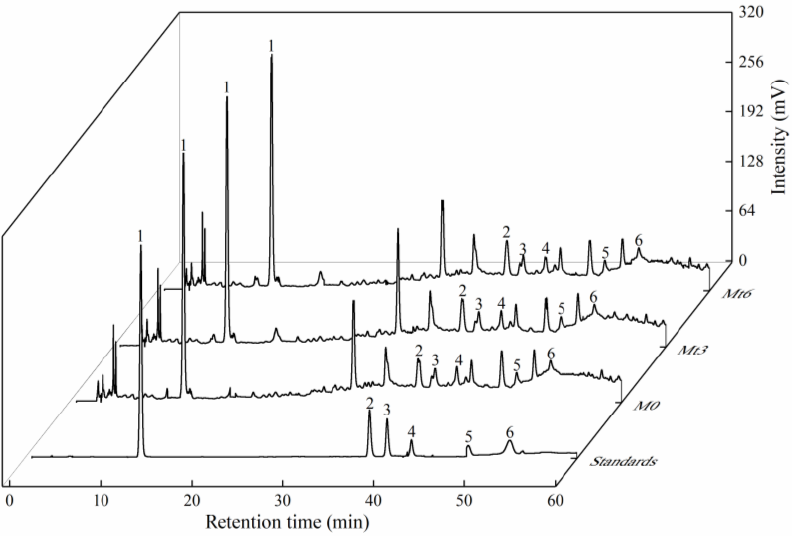
Figure 4. HPLC fingerprint chromatograms of standards, M 0 , M t3 , and M t6 at 280 nm. 1 — gallic acid; 2 — caffeic acid; 3 — syringic acid; 4 — (+)-catechin; 5 — Cy-3-glu; 6 — Mv-3-glu.